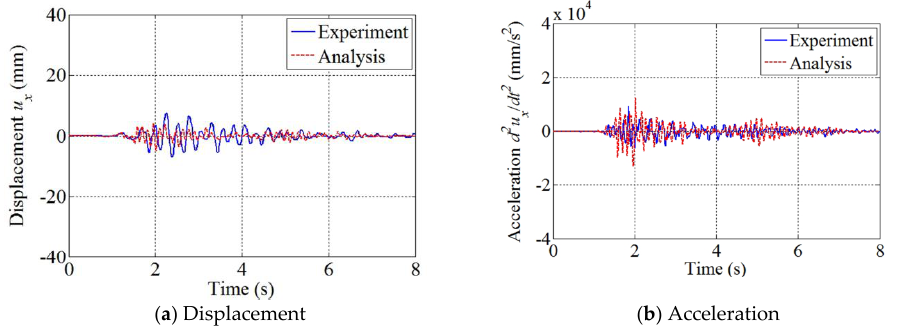
Figure 29. Numerical and experimental responses in the x direction due to real Northridge aftershock of Run 23; responses sampled at point A on the third floor. Table 9. Absolute maximum displacement at point A on the third floor.